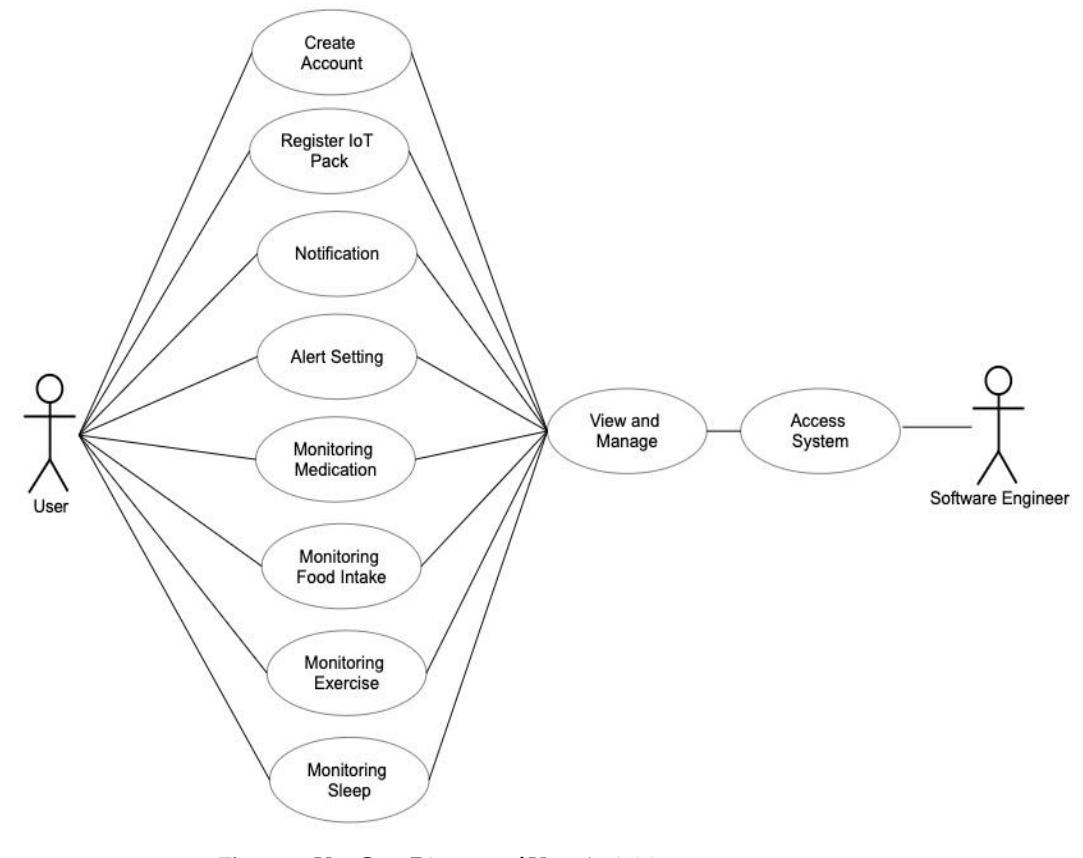
Figure 3. Use Case Diagram of User Activities.